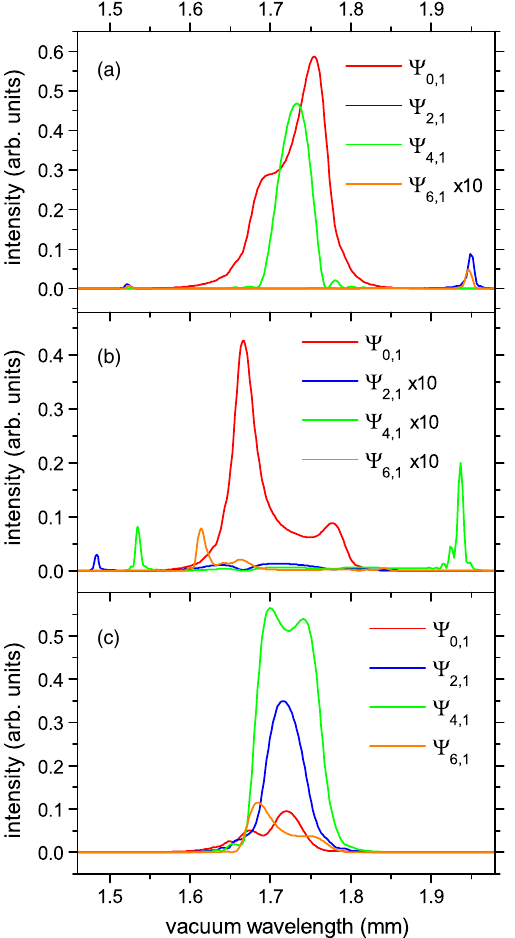
FIG. 7. The spectral density distributions of the Ψ 0 and Ψ 6 modes plotted at δ L ¼ − 28 mm for z ; 1 2 . 3 m (b), and z z R ¼ normalized with respect to the pulse